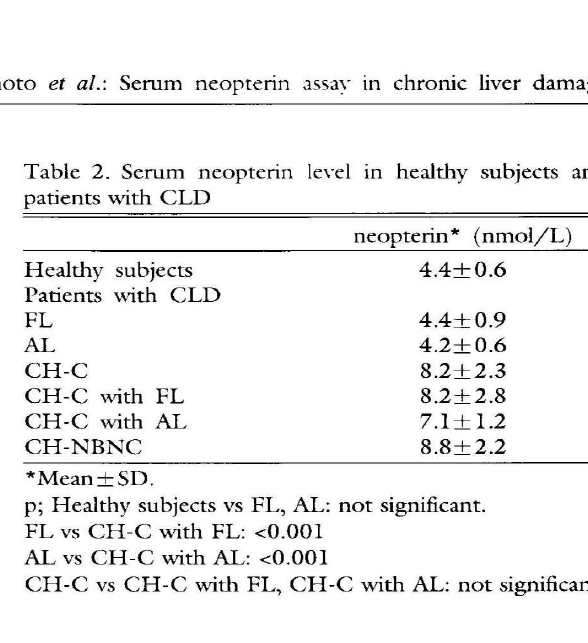
2 shows the mean serum level of neopterin in the healthy subjects and the CLD patients. The mean neopterin level in the healthy men and women was 4.S±0.2 nmoljL and 4.3±